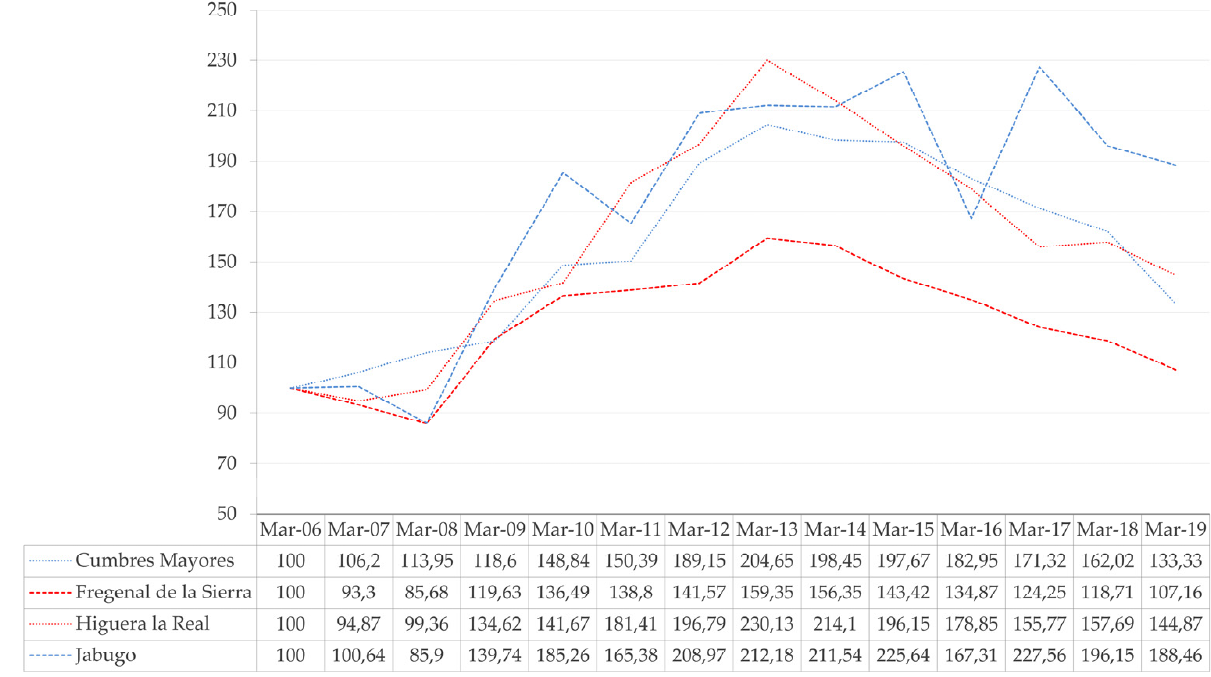
Figure 13. Industrial unemployment registered in the LPS-IPTI (index 100 = March 2006). Source: [101]. Authors own elaboration.